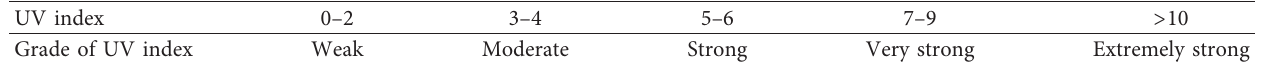
Table 3: Grade of UV intensity.